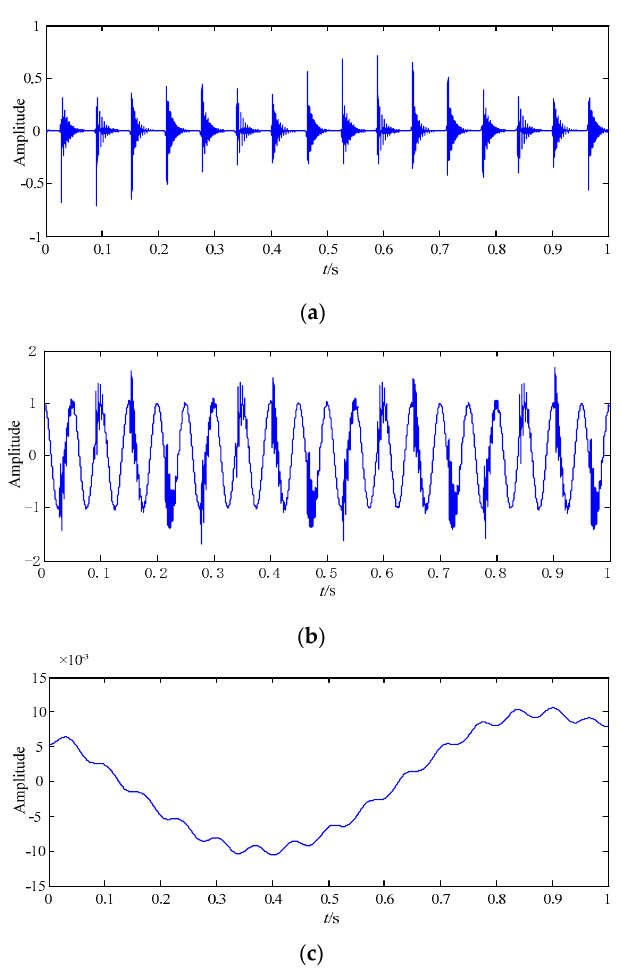
Figure 5. The results of the simulated signal based on empirical wavelet transform (EWT). ( a ) F 3 ; ( b ) F 2 ; ( c ) F 1 .